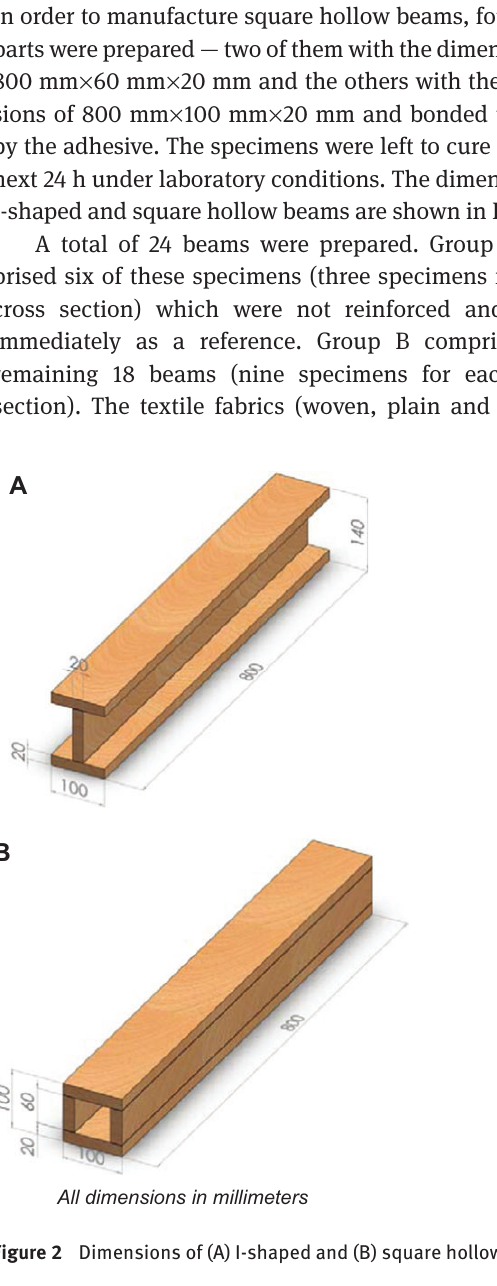
Figure 2 Dimensions of (A) I-shaped and (B) square hollow